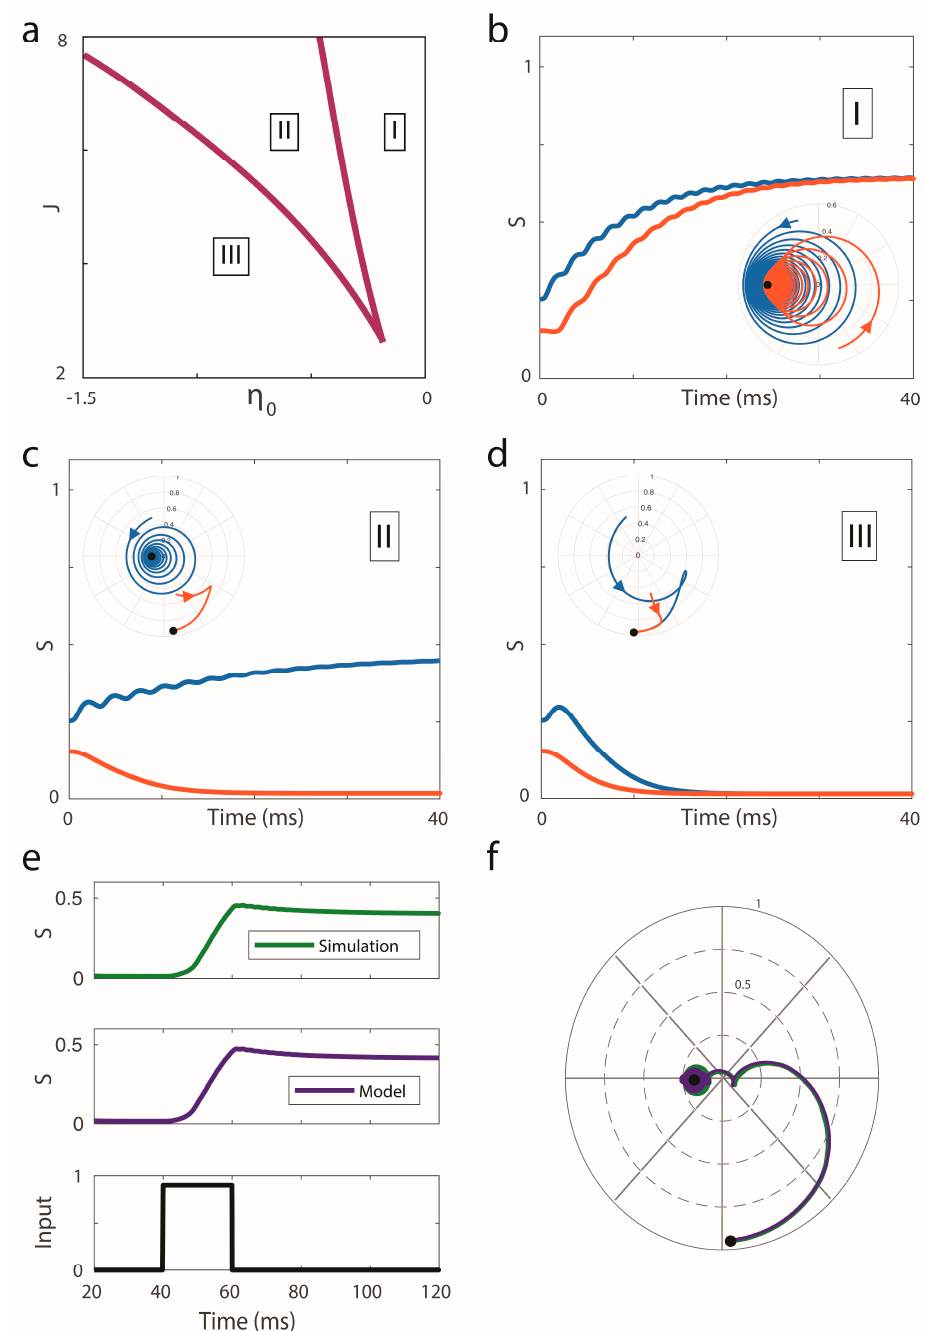
Figure 1. Solutions of the proposed model for the case of a unique excitatory population. ( a ) Bifurcation diagram of the system in the ( η 0 , J ) plane for a case with τ = 2 ms and ∆ = 0.1. The curves denote saddle node bifurcations. Three regions corresponding to the different types of solutions can be identified. ( b – d ) Simulations for different initial conditions. Regions I and III present a unique stationary attracting solution, while region II of parameter space presents bi-stability. Insets show the evolution of the order parameter of the system, with black dots representing the attractive fixed points. ( e ) Agreement between the reduced model and a simulation of a system of oscillators (15,000 units, using a time step of ∆ t = 0.001 s ) ). The rate used to drive the system was computed as the number of oscillators crossing the value θ = π , divided by the total number of oscillators and the time step ∆ t . ( f ) Evolution of the order parameter for the model and the